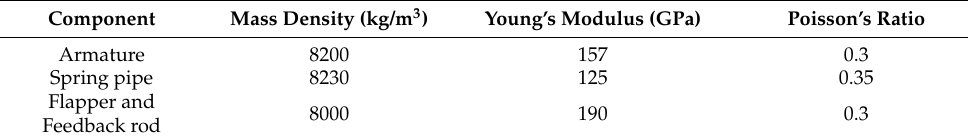
Table 5. Physical property parameters of the armature assembly.